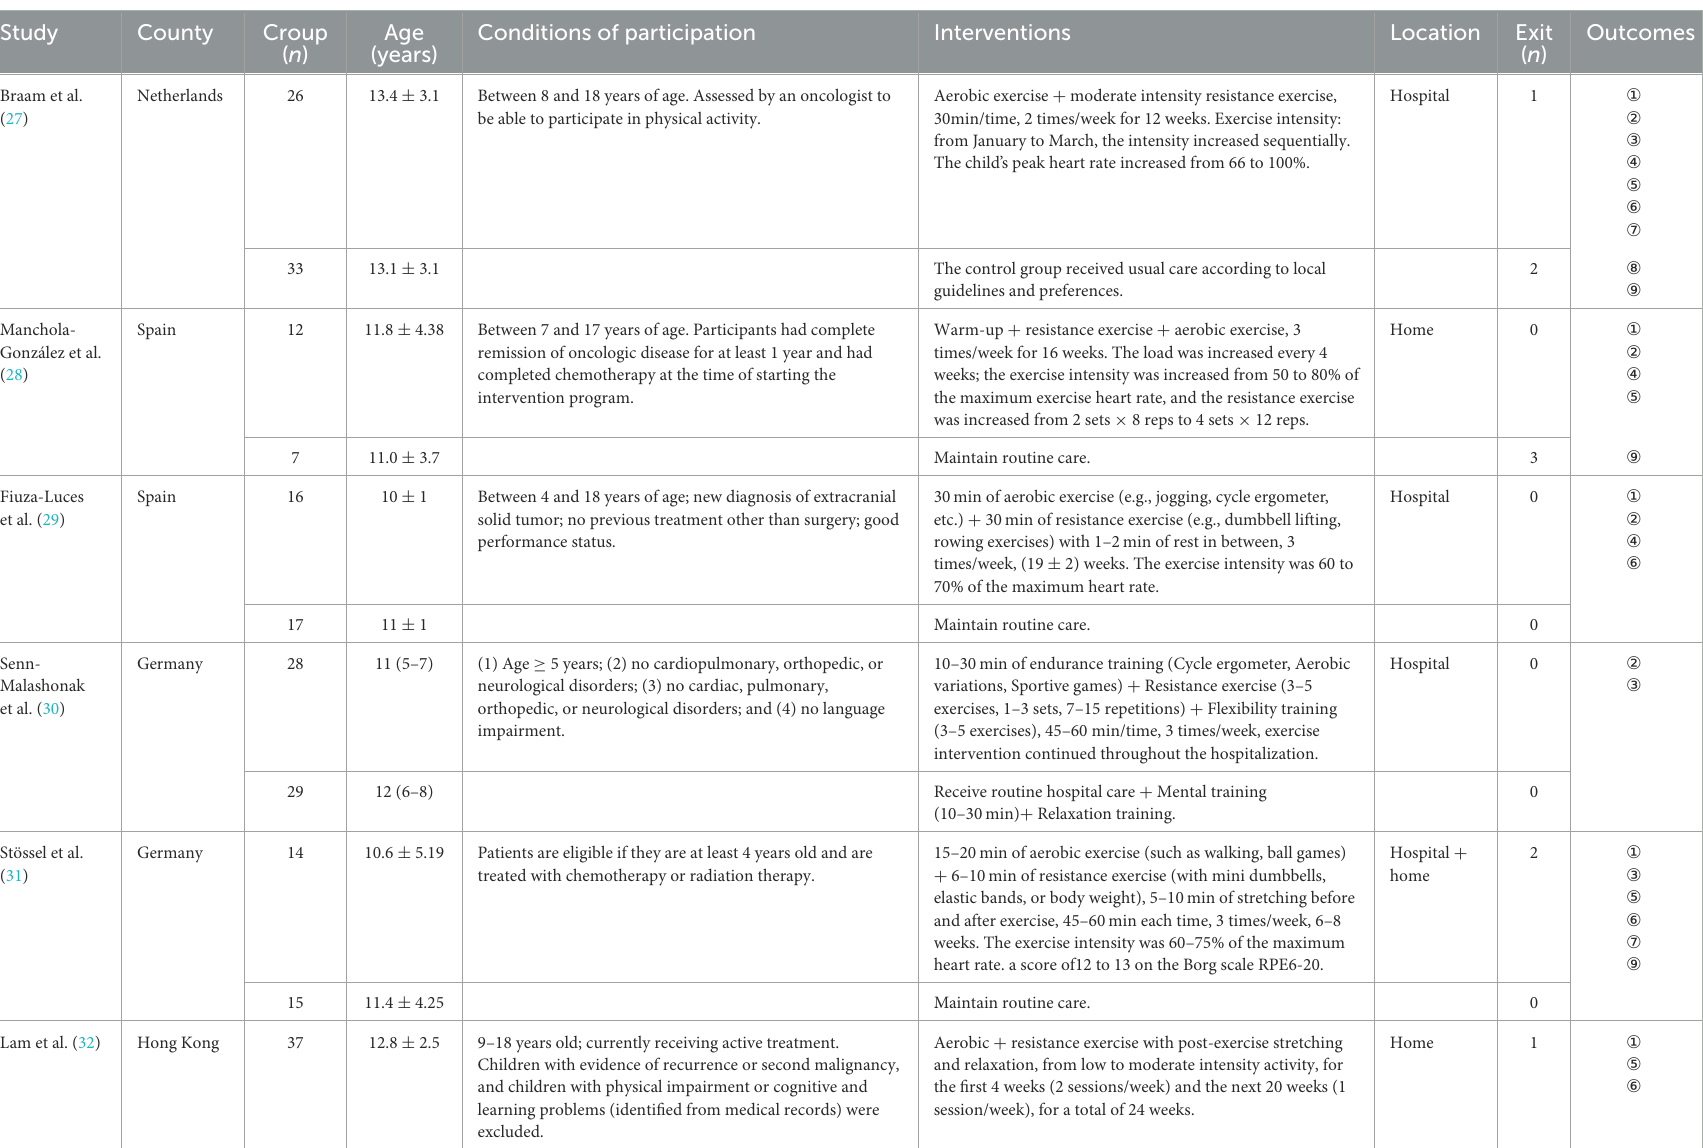
TABLE 1 The baseline characteristics of included